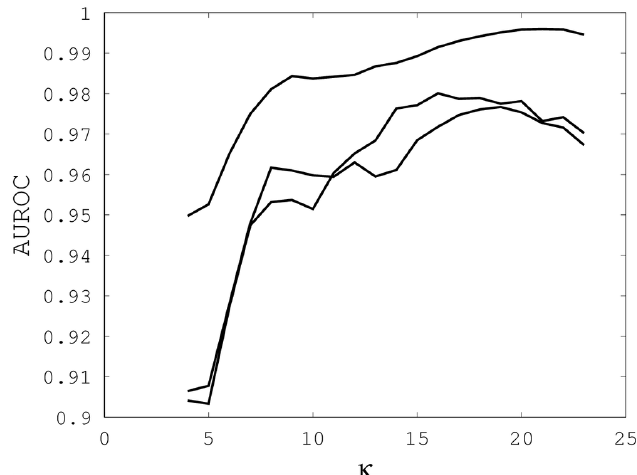
) for each ρ . Each of the three curves corresponds c o